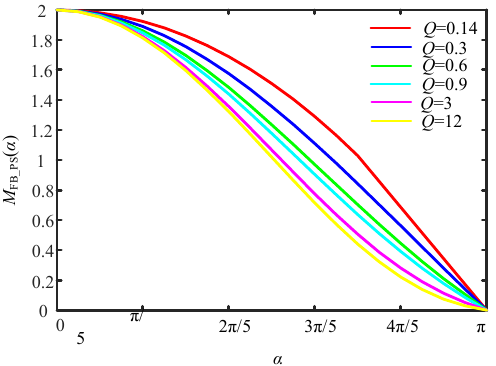
Figure 13. M FB_PS gain curve in full-bridge phase-shift mode.